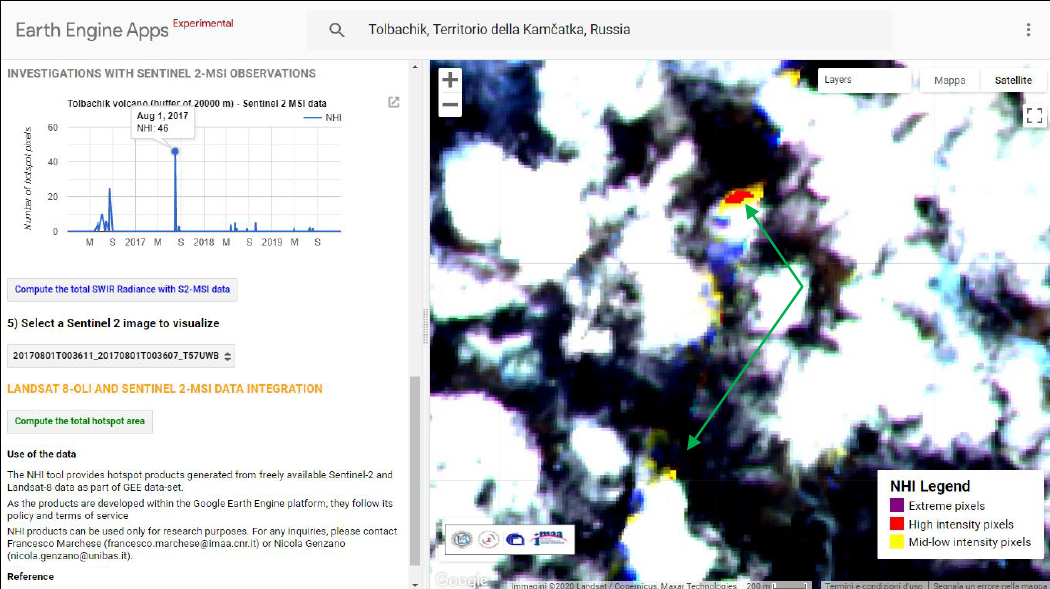
Figure 4. Example of false positives (see red / yellow pixels indicated by the green arrows) a ff ecting the area of the Tolbachick volcano, owing to residual multispectral misregistration issues and striping of the SWIR bands. In background, the RGB product from Sentinel-2 MSI data of 1 August 2017.